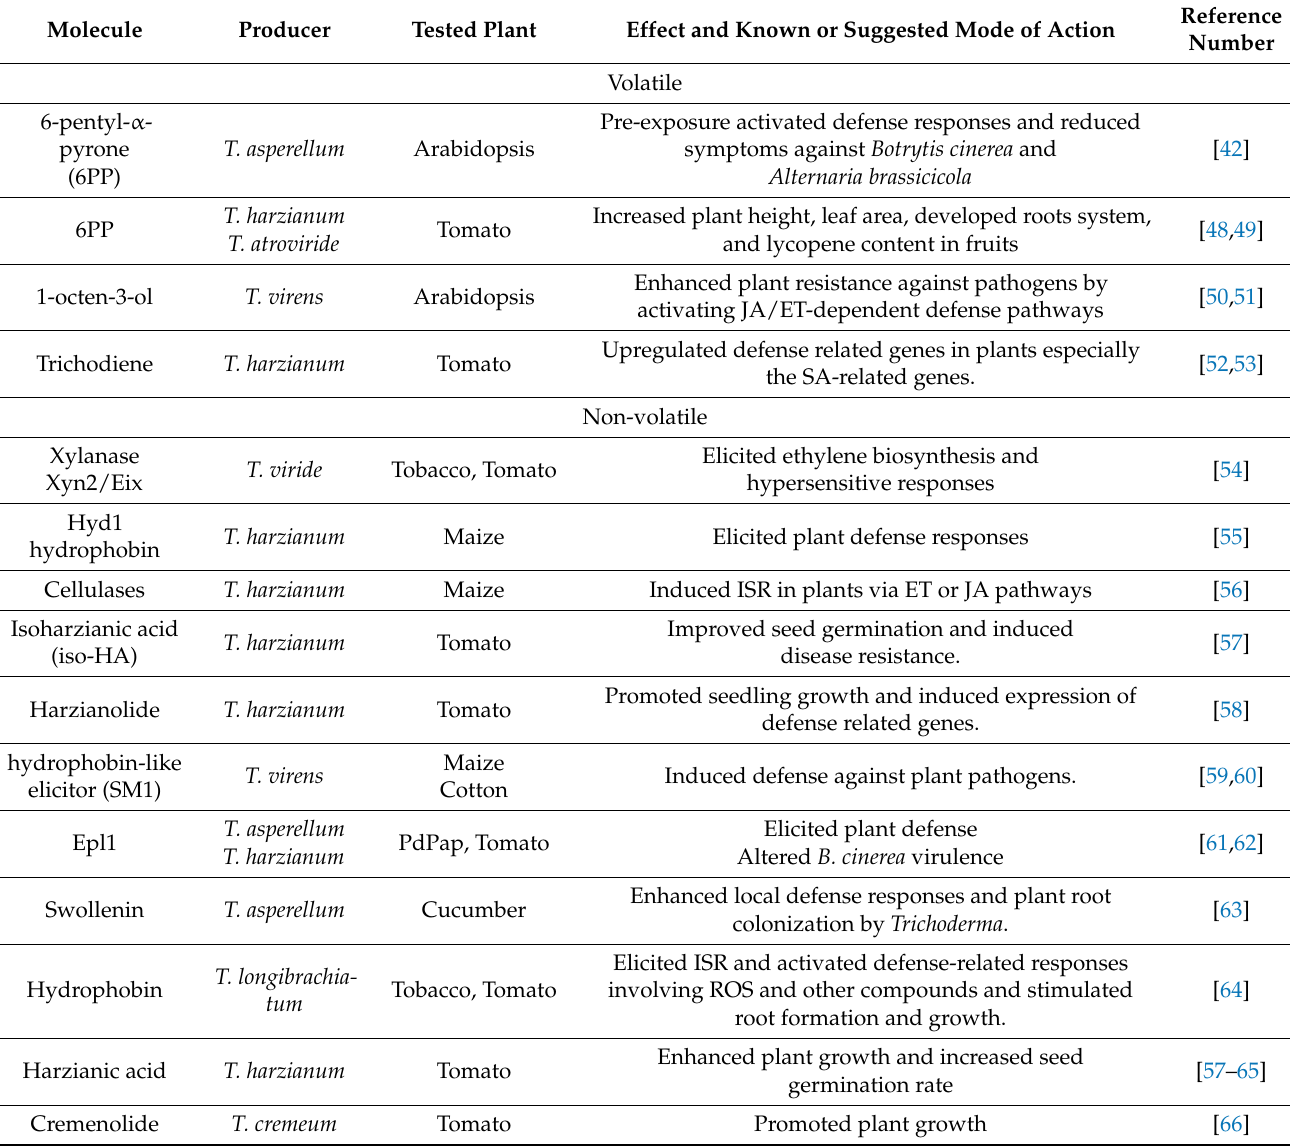
Table 1. Example of molecules secreted by Trichoderma spp. that modulate plant growth, defense, and physiology.